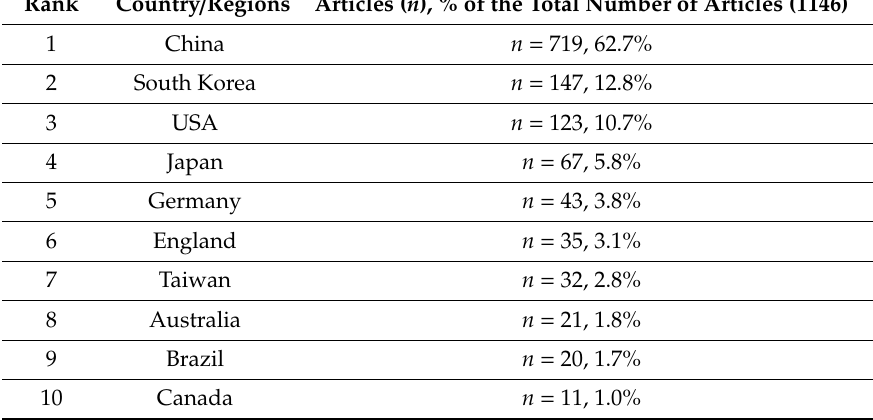
Table 1. The 10 countries that have published the highest numbers of original and review articles investigating moxibustion.